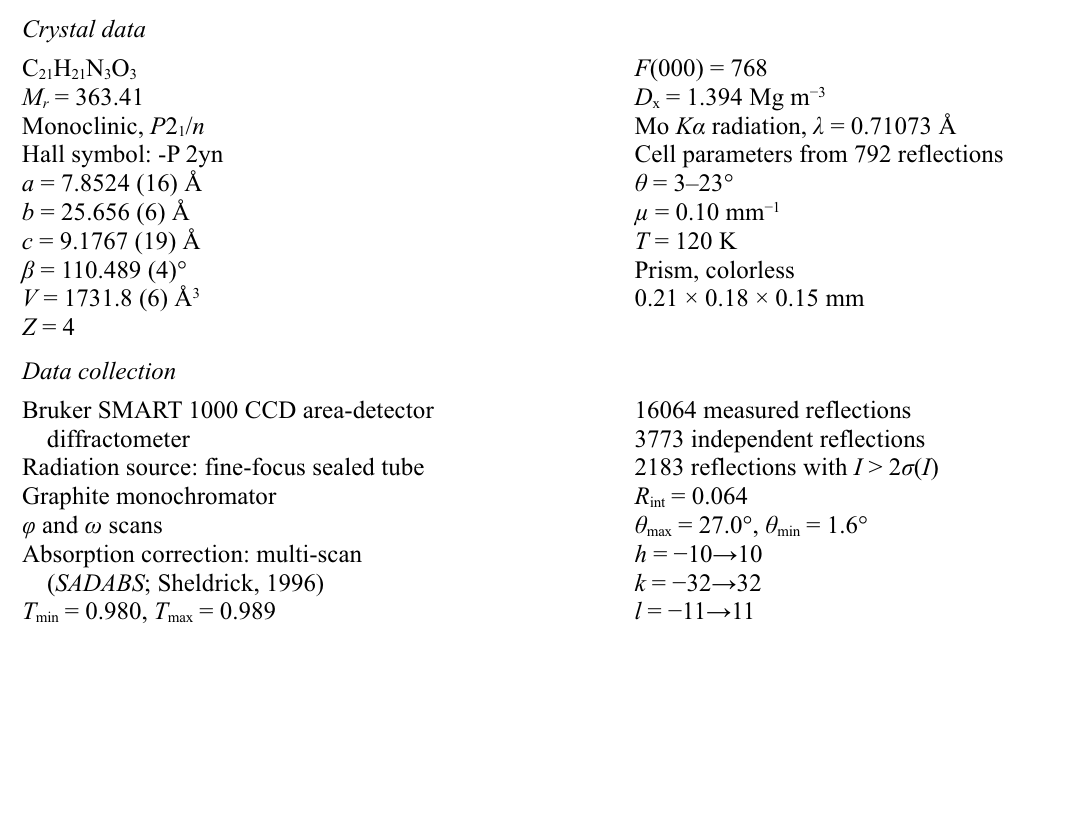
Figure 2 Packing diagram of the molecules, viewed down the c axis. 2 ′ -Methyl-2 ′ -nitro-1 ′ -phenyl-2 ′ ,3 ′ ,5 ′ ,6 ′ ,7 ′ ,7a ′ -hexahydrospiro[indoline- 3,3 ′ -1 ′